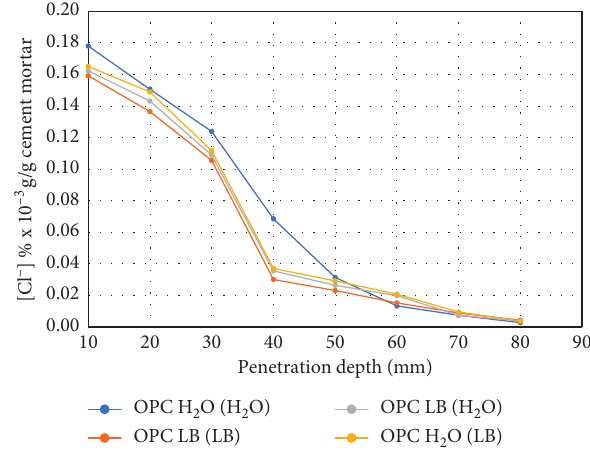
Figure 7: Chloride ion concentration at different depth of pene- tration for control OPC and varied Lysinibacillus sphaericus mi- crobial mortars.